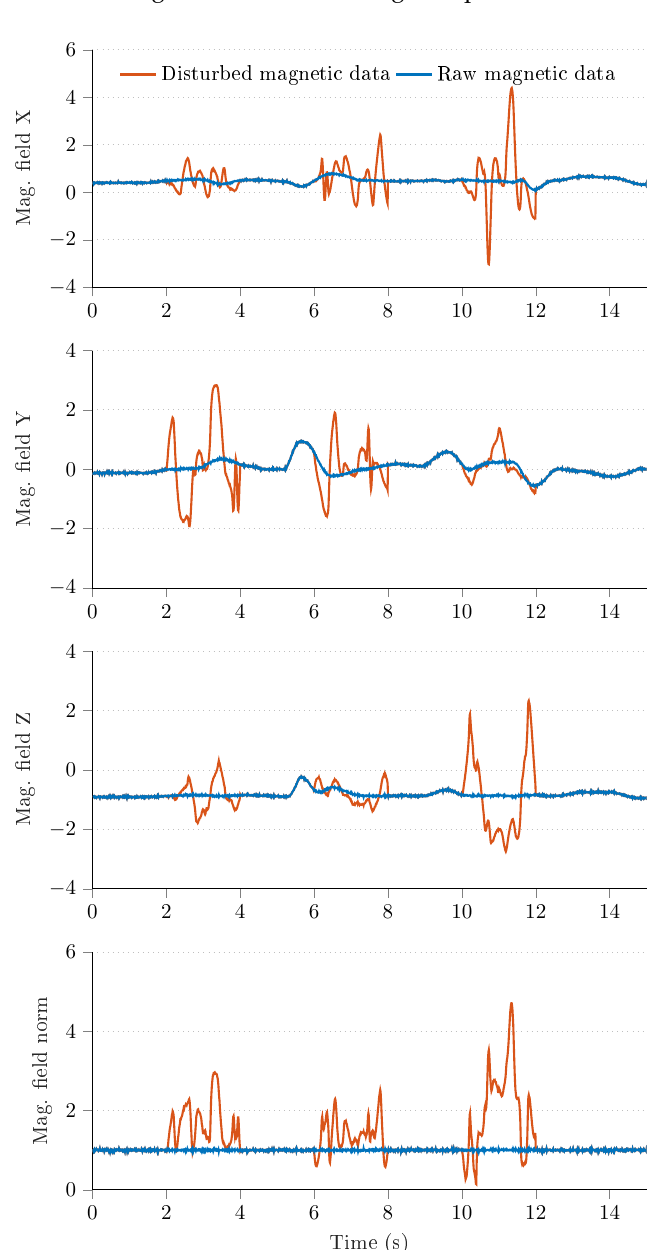
Figure 6. Magnetometer data before (blue curves) and after (red curves) the artificial magnetic